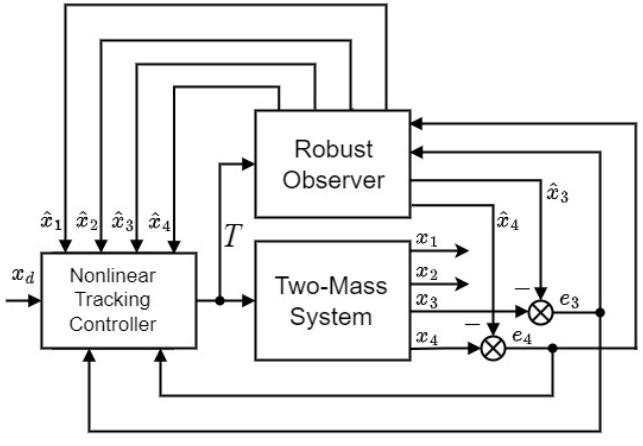
Figure 1. The control system schema.